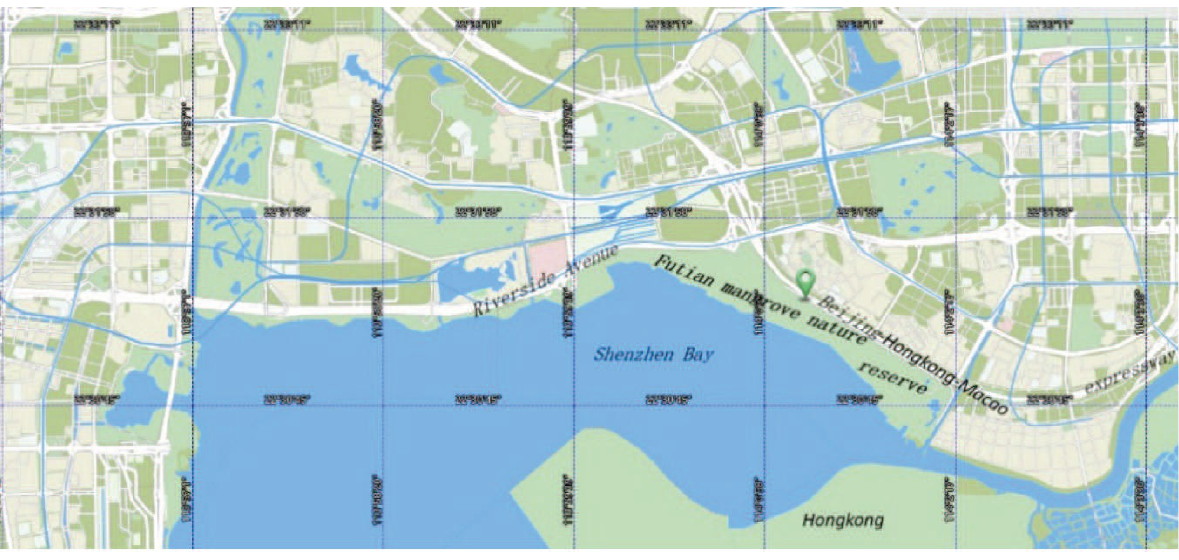
Fig. 1 Map of Futian